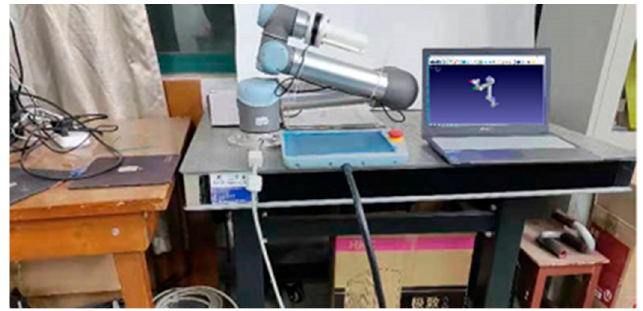
Figure 1. Communicating the UR5 robot with the computer software.